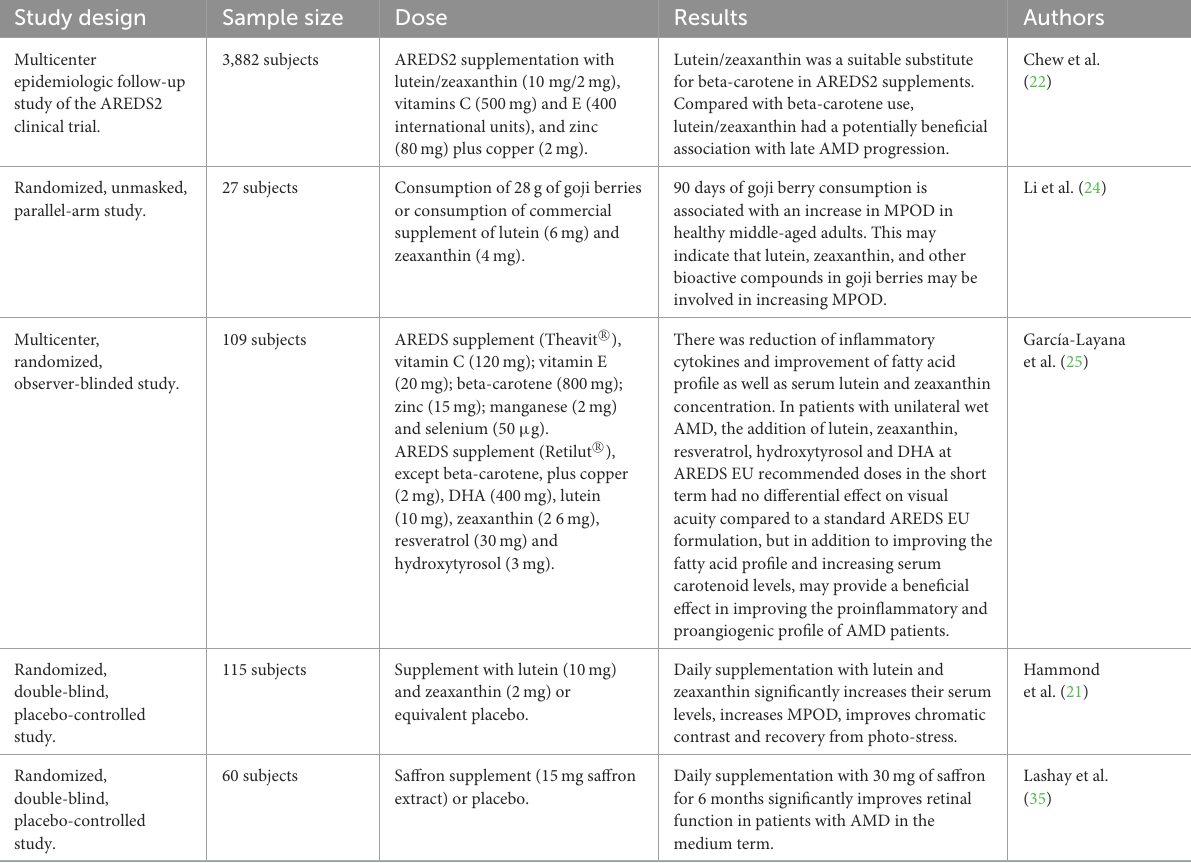
TABLE 1 Clinical trials on the treatment of AMD and carotenoid